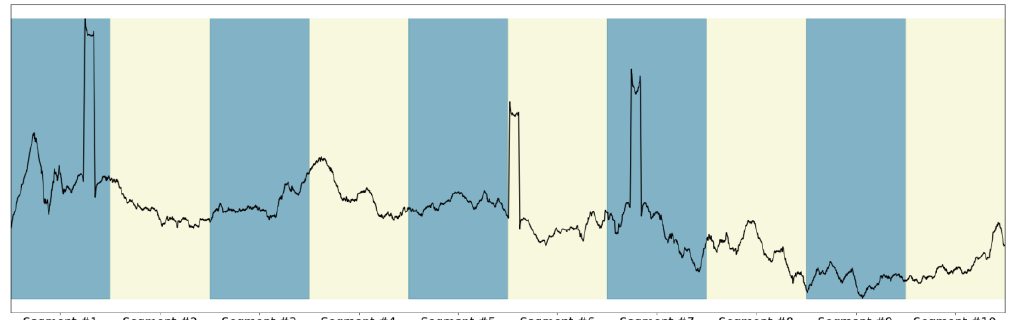
Table 3. Division of samples to each dataset .